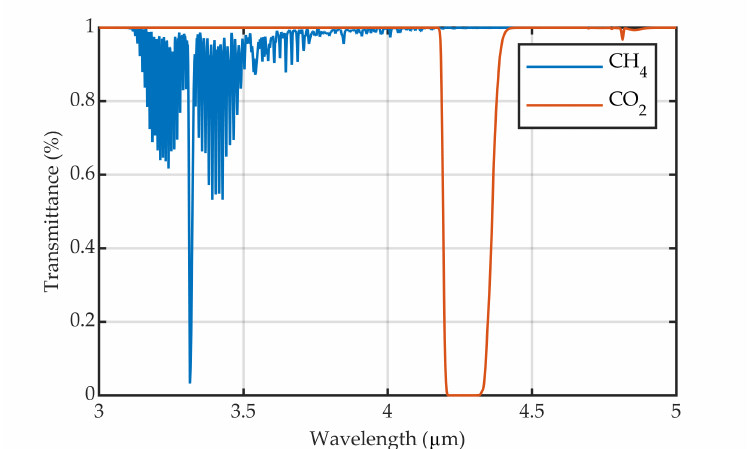
Figure 5. Transmission spectra of pure CO 2 and a mixture of CH 4 and N 2 ; the mole fractions of the gas mixture are 0.15 and 0.85, respectively. Both gases at ambient temperature and pressure for an optical path of 20 cm. The spectra have been obtained using the HITRAN database